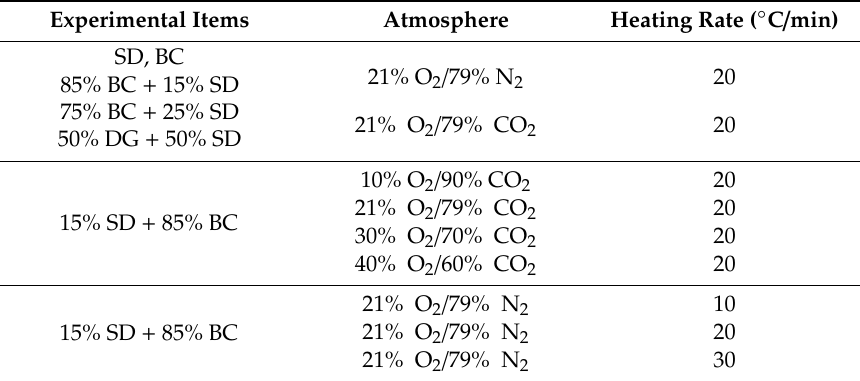
Table 2. Experimental cases.